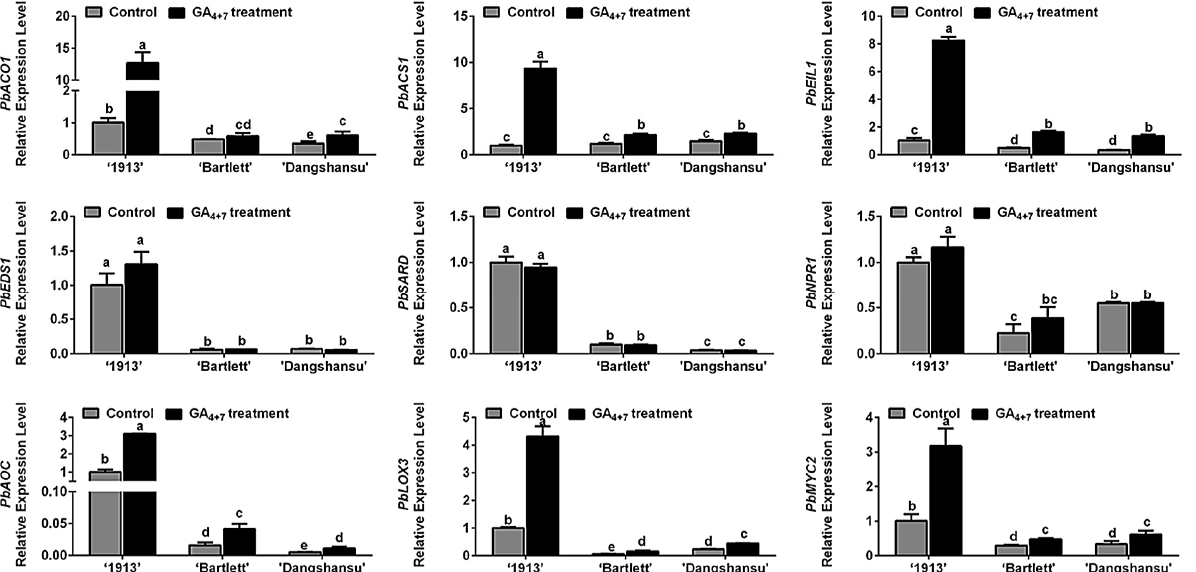
Figure 3. Relationship analyses between ethylene, JA and SA with GA 4+7 treatment. The expression profile analyses of ethylene, JA, SA synthesis and signaling response-related genes between GA 4+7 -treated and untreated ovules at 8 DAT. The data are mean ± SD of three biological replicates. Error bars represent the standard deviation. Different lowercase letters indicate significant difference at p < 0.05 (Duncan’s multiple range